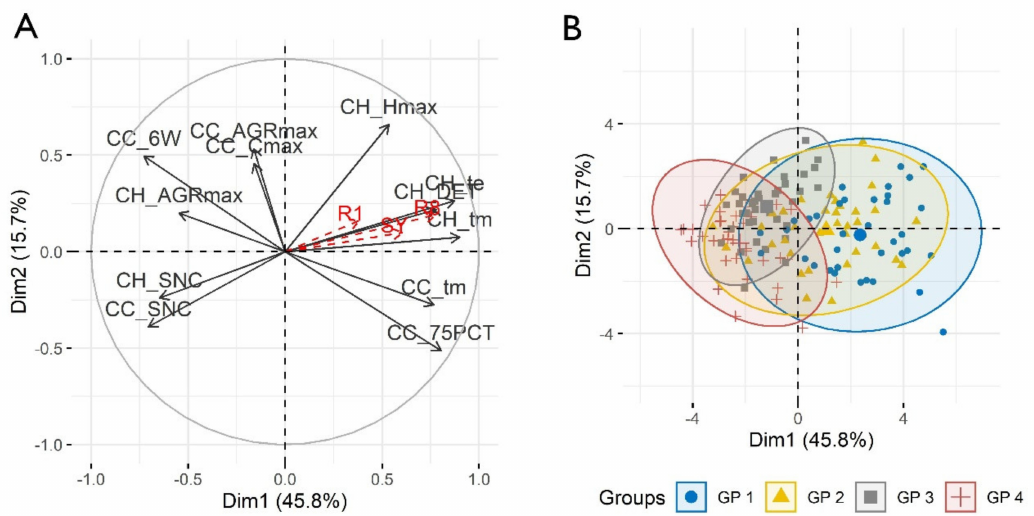
Figure 6. PCA of ( a ) UAV derived phenotypic parameters and field observations (in red) and ( b ) individual plots (n = 148) with color code related to the group / sowing date. For the abbreviations, see Table 1.